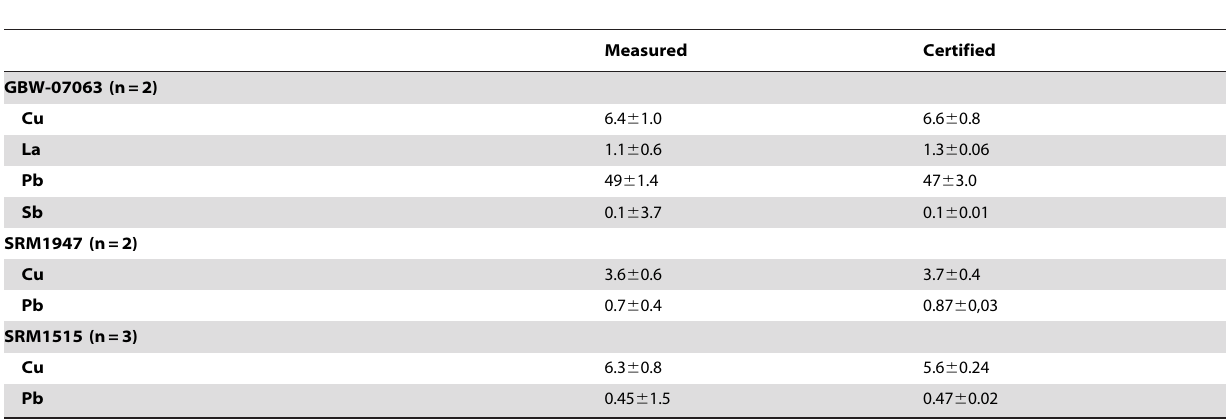
Table 2. Cu, Pb and La determined by Q-ICP-MS compared to certified values of SRM1947, SRM1515 and GBW-07063 (mean 6 standard deviation, mg.kg 2 1 ).